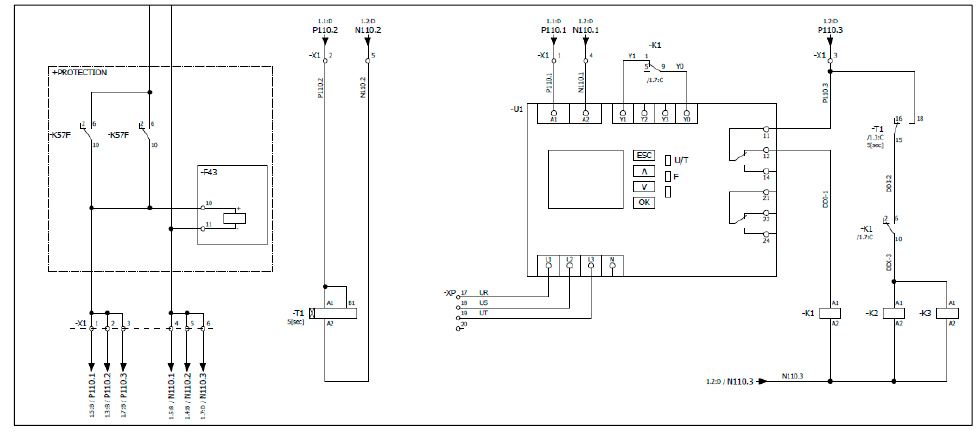
Figure 22. A relay circuit.